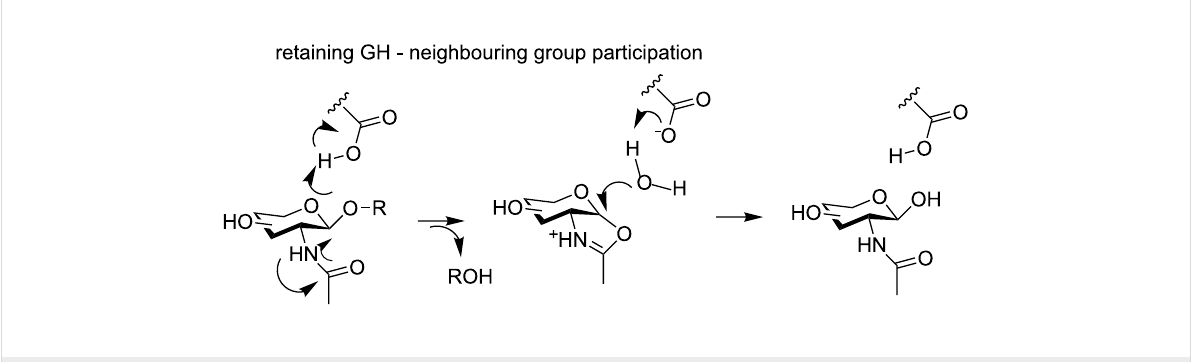
Figure 6: Neighbouring group participation mechanism of retaining the O -GHs-catalysed hydrolysis.